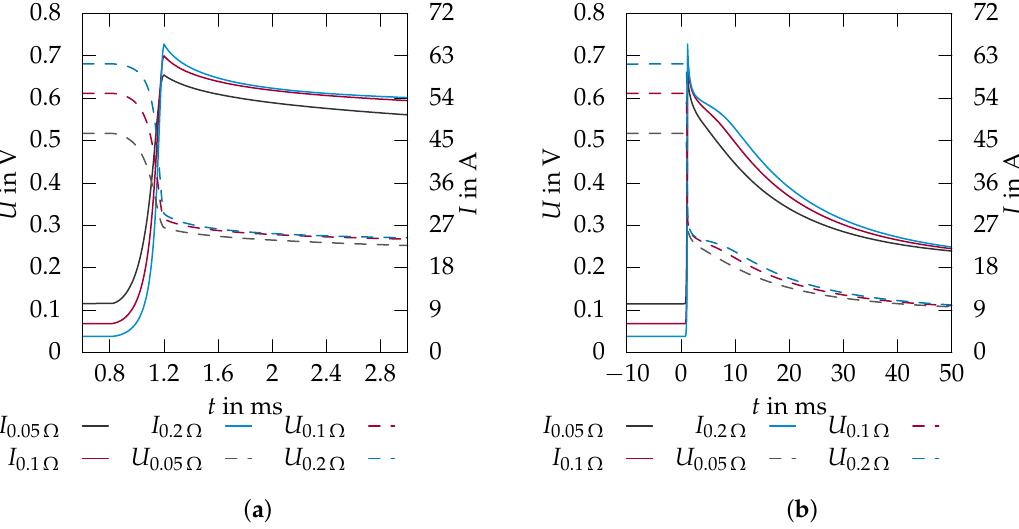
Figure 13. Current (solid) and voltage (dashed) for all load variations (0.05 Ω (black), 0.1 Ω (red) and 0.2 Ω (red)) in the simulation ( a ) during the switching of the relay and ( b ) until